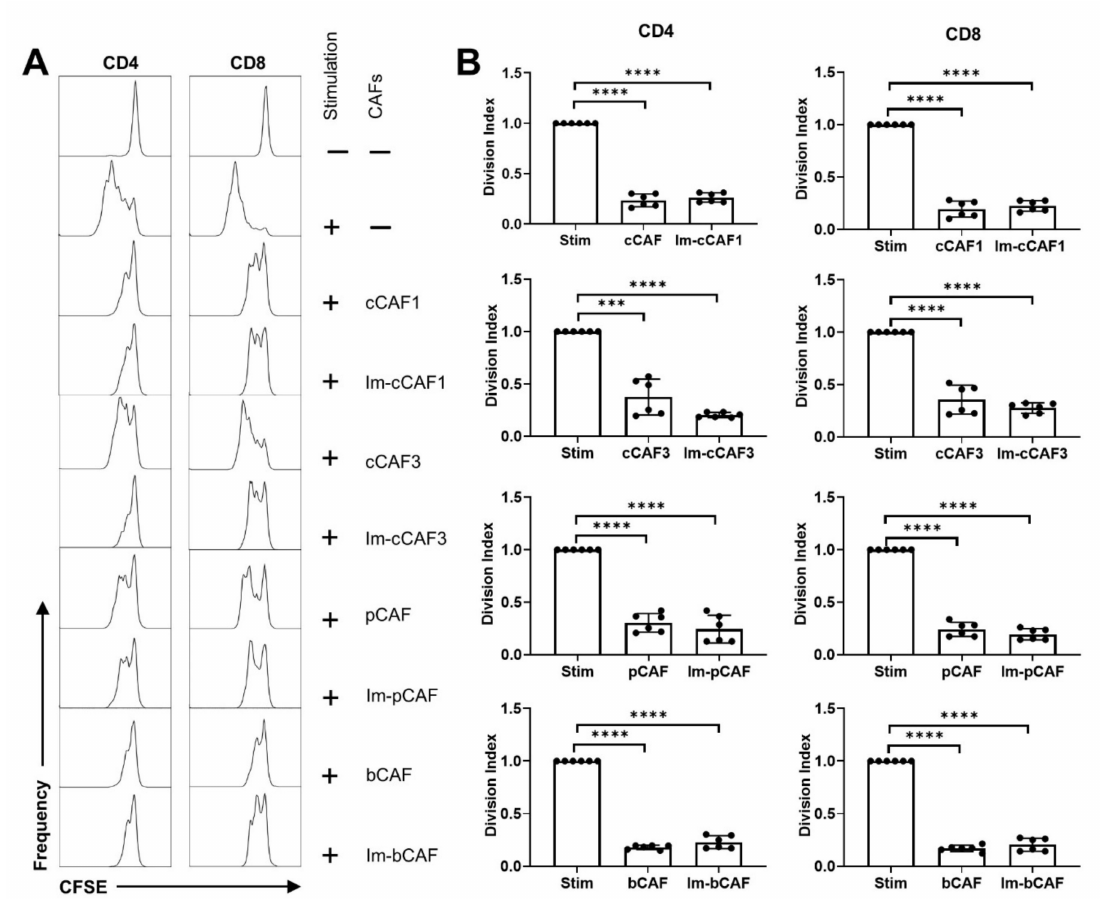
Figure 6. Human primary CAFs and immortalized CAFs inhibit T-cell proliferation. ( A ). Carboxyfluorescein succinimidyl ester (CFSE)-labelled peripheral blood mononuclear cells (PBMCs) (5 × 10 5 ) were cultured with or without CAFs grown to 90% confluency in 96-well plates, with or without anti-CD3/CD28/CD2-coated activation beads. After 96 h, cells were harvested and analyzed using flow cytometry. Histograms depict T-cell CFSE staining on plots gated for CD3 and CD4 or CD8. ( B ). Normalized division index of gated CFSE+ T cells, which were cultured for 96 h unstimulated or stimulated with anti-CD3/CD28/CD2-coated beads, with or without primary or Im-CAFs. Data are normalized to stimulated T cell controls and represent mean values ± SD of 6 replicates from 2 independent experiments. Data represent primary cells evaluated at passage 3 and immortalized cells at passages 4–13. Statistics: one sample t test, *** p < 0.001, **** p <